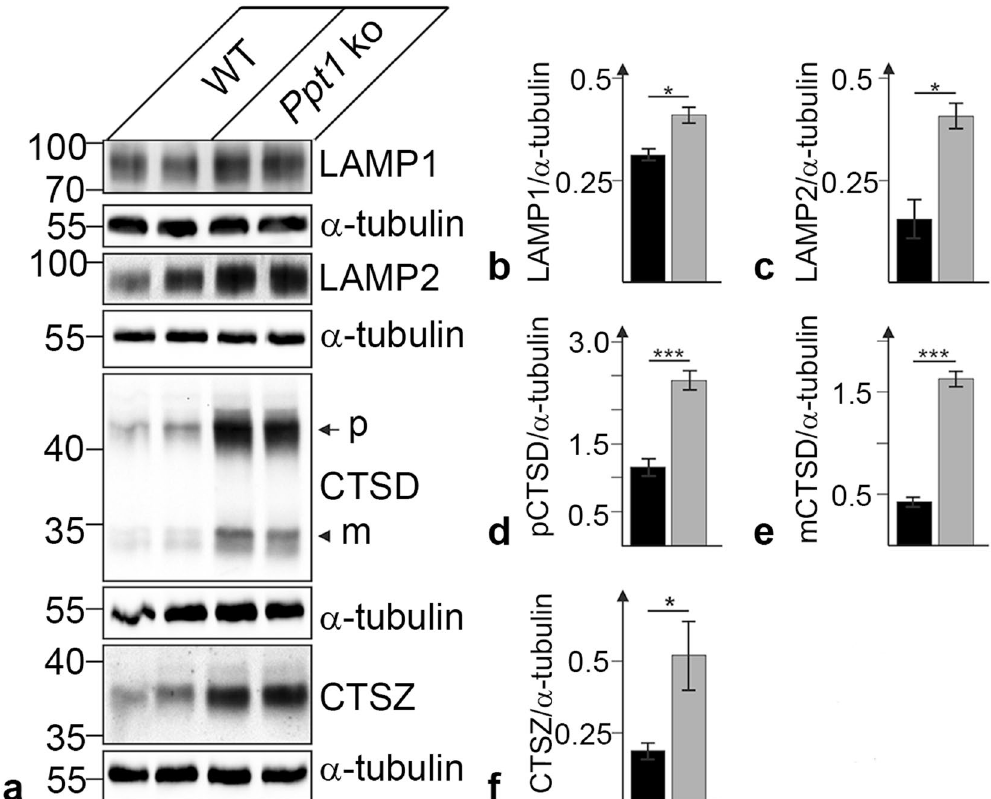
Figure 5. Dysregulation of lysosomal proteins in Ppt1 ko retinas. Immunoblot analyses revealed elevated levels of LAMP1, LAMP2, CTSD and CTSZ in 240-day-old Ppt1 ko retinas when compared to age-matched wild-type retinas ( a ). α -tubulin immunoblotting was performed as a loading control. Positions of the molecular mass markers and the precursor ( p ) and mature (m) form of CTSD are indicated ( a ). Quantitative analyses of immunoblots demonstrated significantly increased levels of LAMP1 ( b ), LAMP2 ( c ), the precursor ( d ) and mature ( e ) form of CTSD, and CTSZ ( f ). Bars represent mean values ( ± SEM) of protein levels from three independent experiments normalized to the amounts of α -tubulin in 240-day-old wild-type (filled bars) and age-matched Ppt1 ko retinas (grey bars). Uncropped blots are shown in Supplementary Fig. 5. * p < 0.05; *** p < 0.001 according to the Student’s